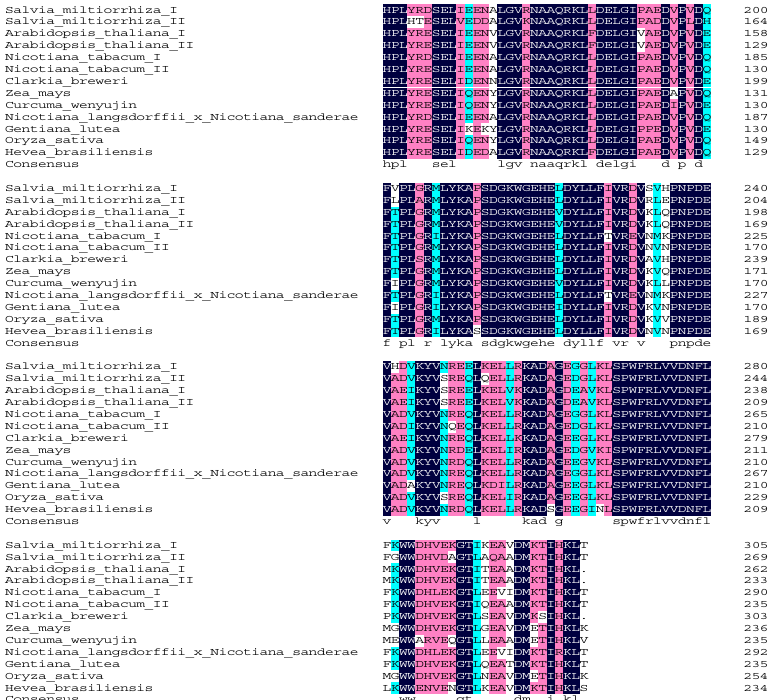
Figure 2. The amino acid sequence alignment of SmIPI1 with IPIs in other plants species. The amino acid accession numbers are as follows: Arabidopsis thaliana I AAB67741.1, Arabidopsis thaliana II AAL57687.1, Salvia miltiorrhiza I ABV08818.1, Salvia miltiorrhiza II JN831106.1, Nicotiana tabacum I